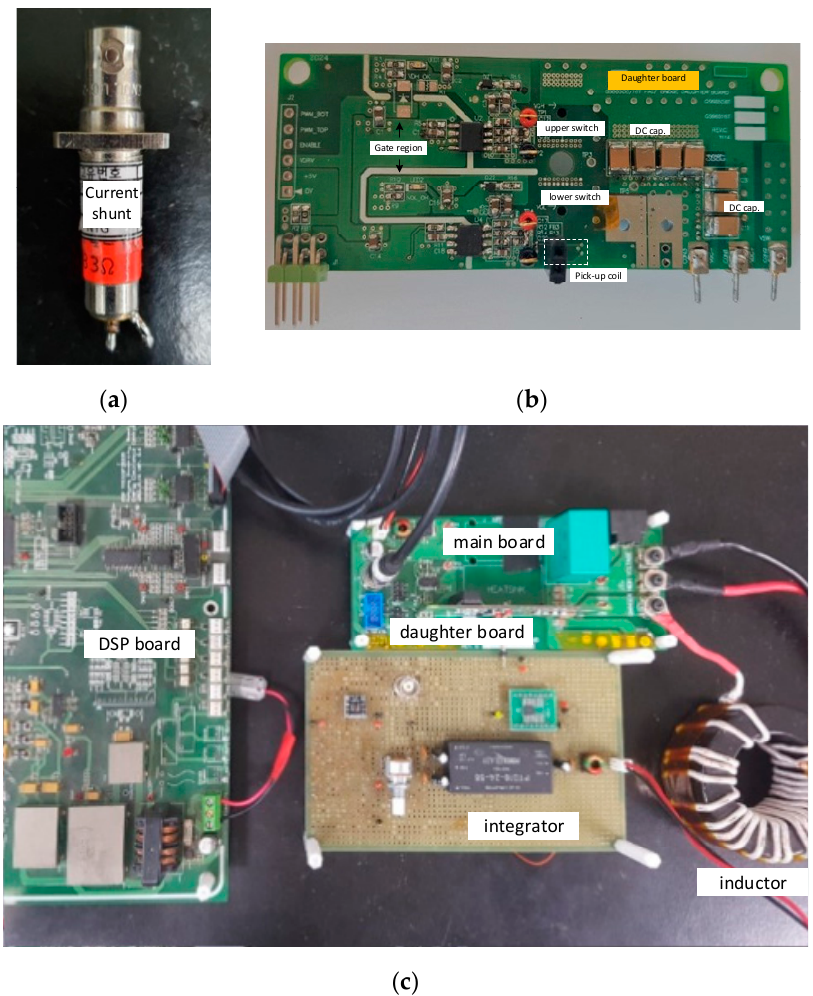
Figure 11. Prototype board of double pulse test: ( a ) current shunt; ( b ) daughter board with pick-up coil; ( c ) overall double pulse test board.